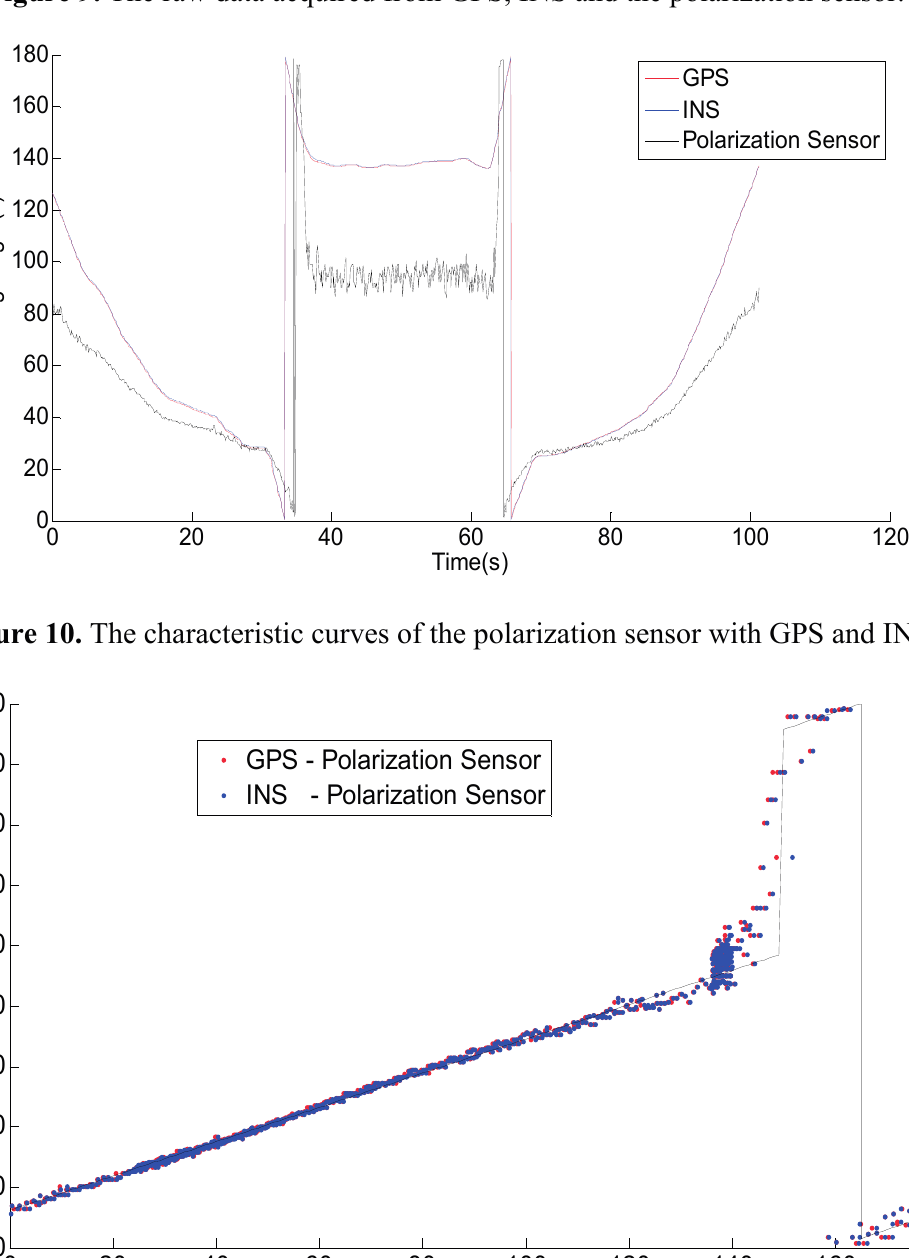
Figure 9. The raw data acquired from GPS, INS and the polarization sensor.